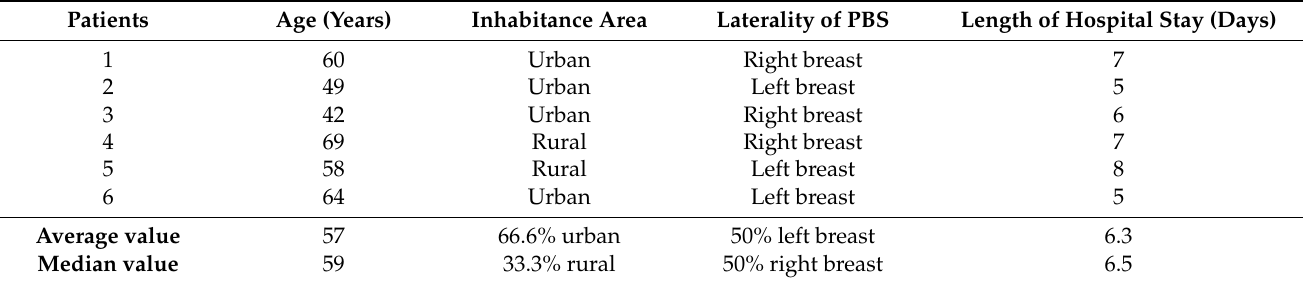
Table 1. Age, environment, tumor localization, and length of hospitalization in patients with breast